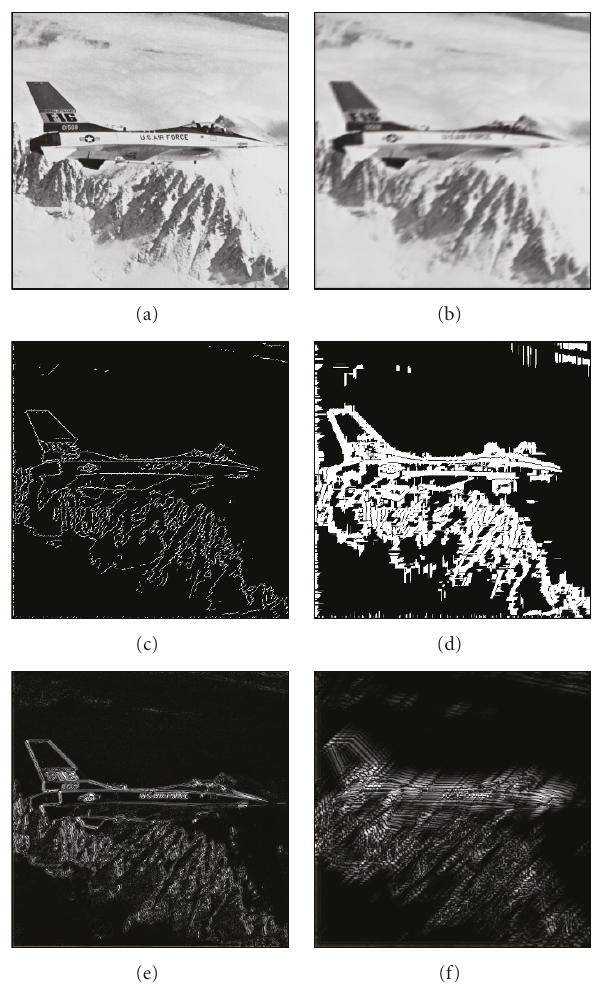
Figure 4: Edgewidth mask construction of observed image. (a) Original image. (b) Blurred image. (c) Edgemap of observed image. (d) Edgewidth mask. (e) Di ff erence image between Figures 4(a) and 4(b). (f) Di ff erence image between Figure 4(b) and the deblurred image with an inaccurate PSF.